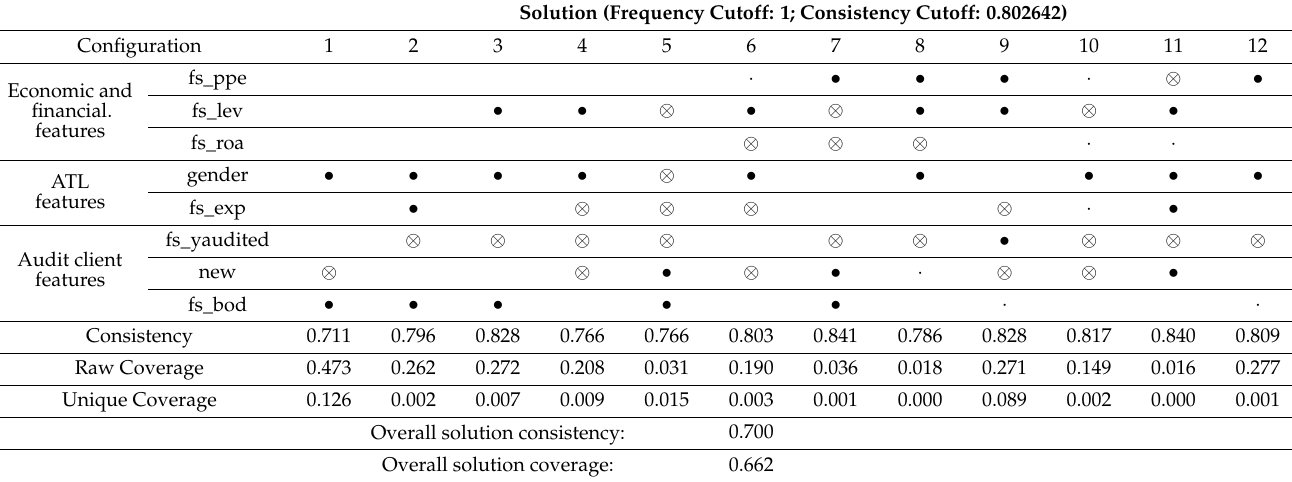
Table 7. Configurations sufficient for the for the presence of errors (Outcome: